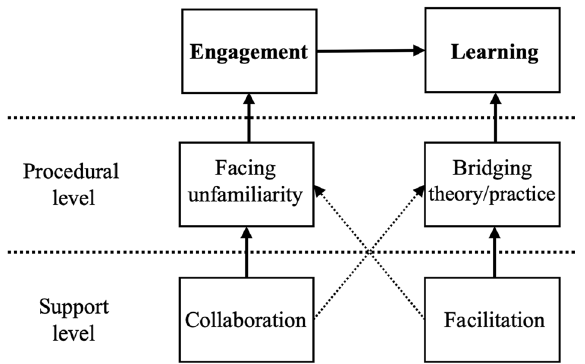
Fig. 3 Category interrelations and connection to engagement and